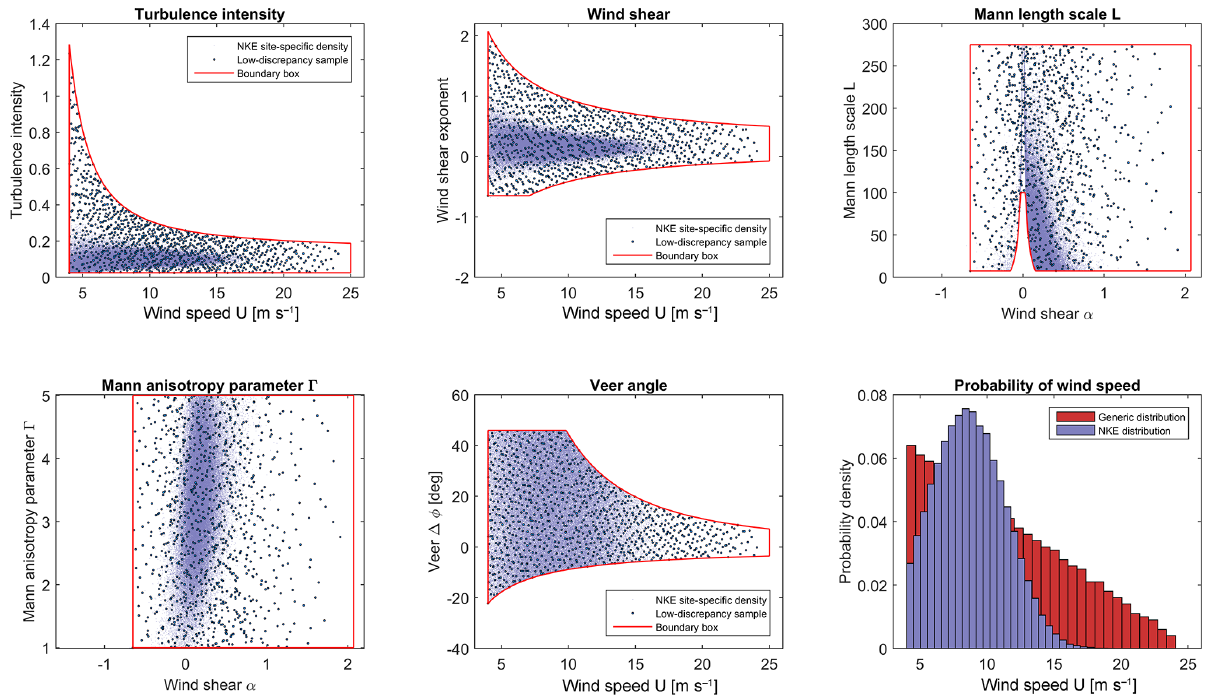
Figure 2. Sample distributions obtained using 1024 low-discrepancy points within a 6-dimensional variable space { U,I u ,α,(cid:49)φ h ,L,(cid:48) } . Here U is beta-distributed, while the other variables are uniformly distributed within their ranges. Solid lines show the sampling space bounds, which are curved due to conditional dependencies. Blue shading shows the site-specific variable distribution for the Nørrekær Enge (NKE) reference site (site 0, cf. Table 5 and Sect.